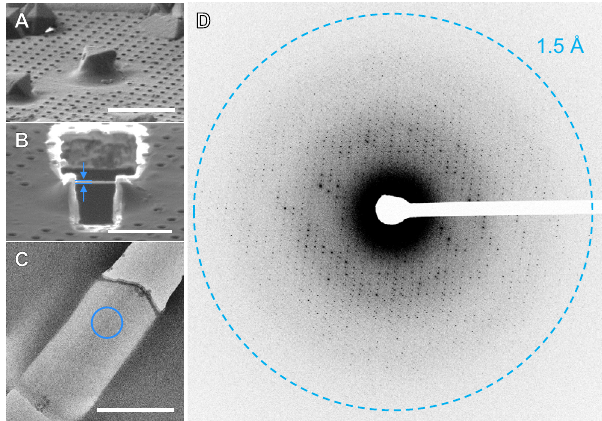
Fig. 2 | Preparing plasma beam milled lamellae of a protein microcrystal. Images of a selected serine proteinase microcrystal before ( A ) and after ( B ) thin- ning the crystal into a thin lamella using a focused ion-beam of argon ions. This lamellashowing cleardelineation ofthe platinum layer,crystal, and vitri fi edmedia at 2200× in the TEM ( C ). D MicroED data corresponding to 4° of data summed together from a direct electron detector. All scale bars 10 µ